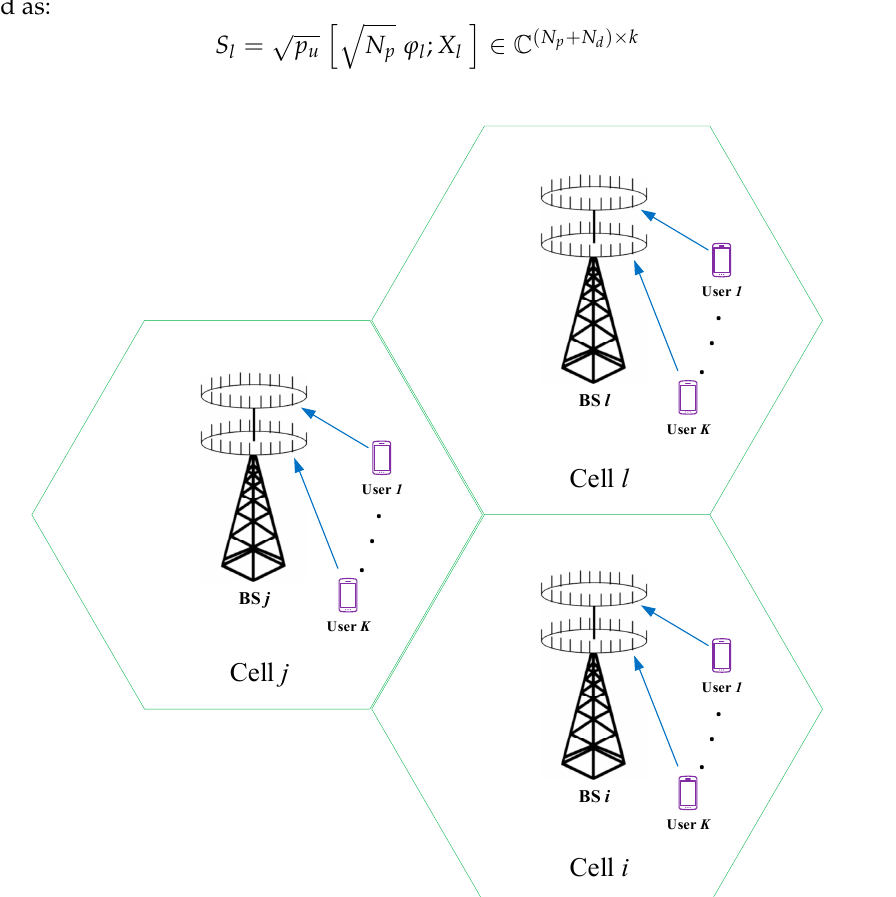
Figure 1. Massive MIMO system model.